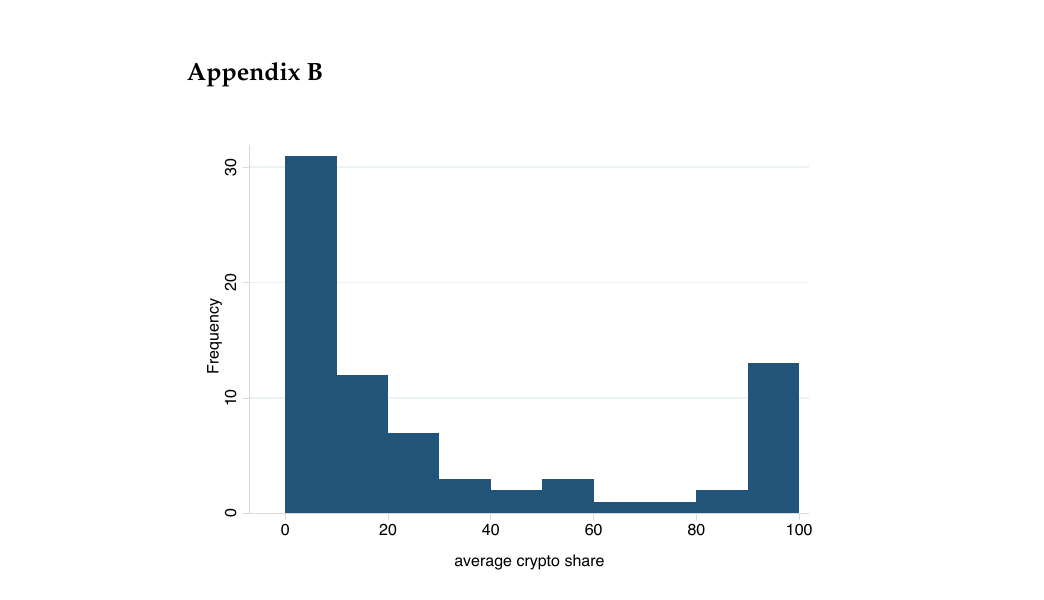
Figure A5. Histogram of average crypto share of crypto owners in their total portfolio. Note: Here, we display a histogram of the shares of crypto-assets in users’ total portfolios. Source: Own data.